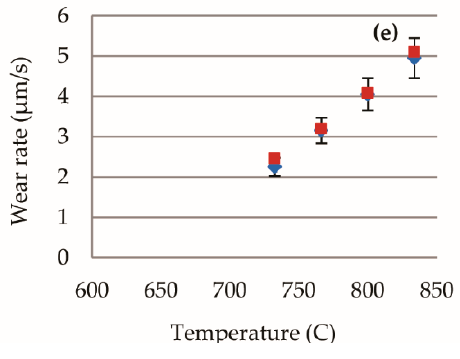
Figure 14. Effect of temperature on tool wear rates acquired experimentally and predicted with Usui model for different cutting parameters.